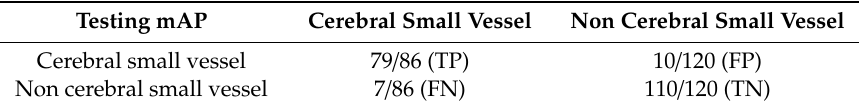
Table 8. Testing mAP of YOLO3 model.